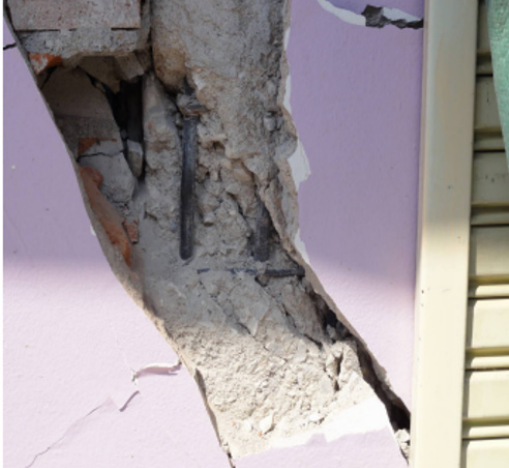
Figure 3. Damage due to load transfer from masonry walls [7].